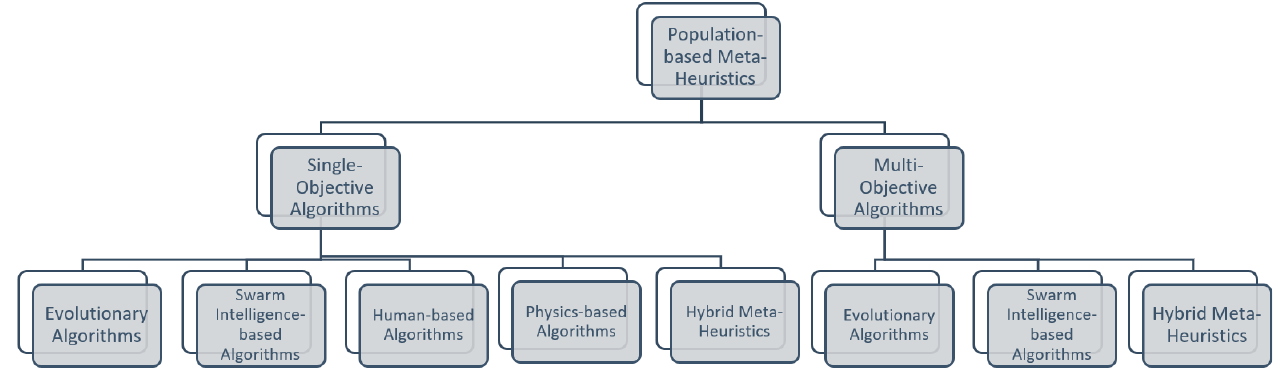
Figure 1. Classification of the population-based Meta-Heuristic algorithms.